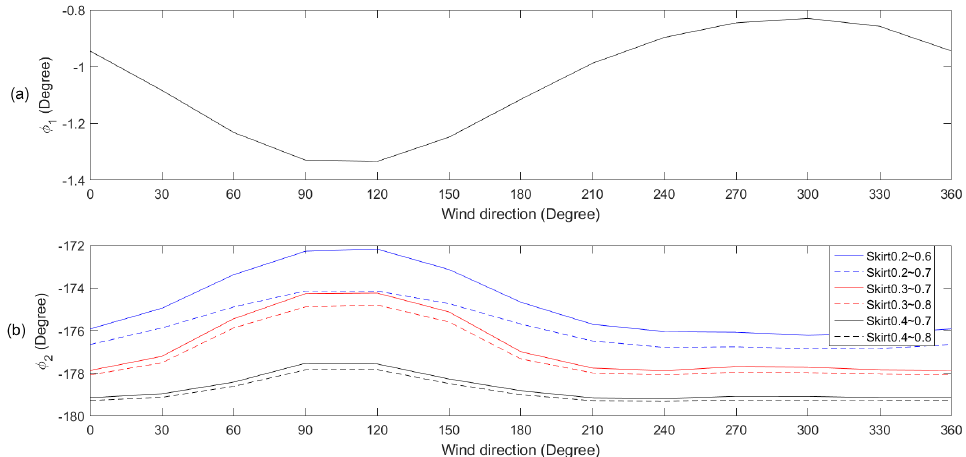
Figure 5. The influence of the DDM skirt’s value on the relation between wind direction and the angles of ( a ) (cid:2030) (cid:2869) and ( b ) (cid:2030) (cid:2870) . The wind speed, the receiver’s elevation, and azimuth are 10 m/s, 75°, and 108°.